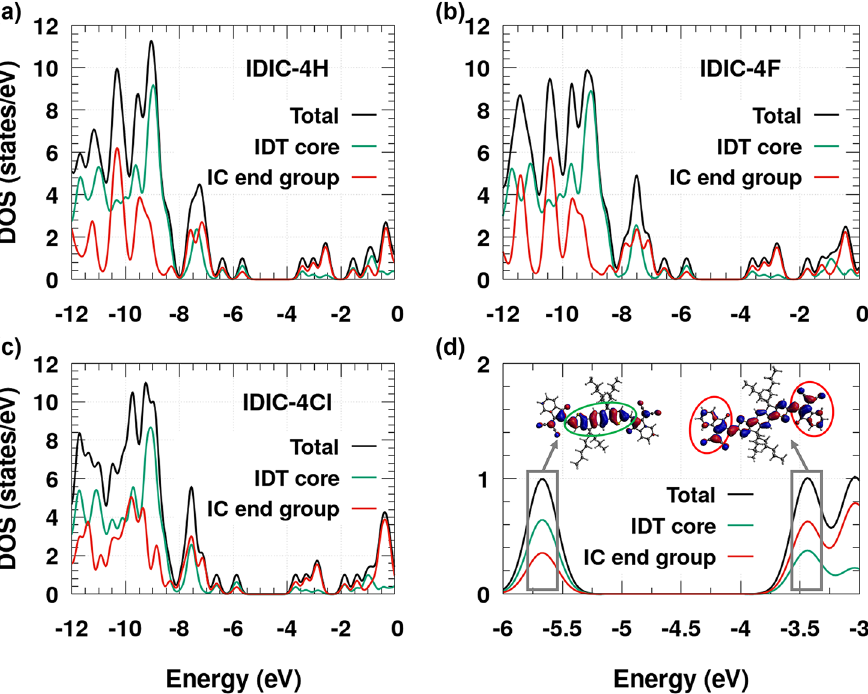
Fig. 4. Total and partial DOS for (a) the parent, (b) the fl uorinated, and (c) the chlorinated compound. (d) Contributions around HOMO and LUMO energy levels for the parent molecule IDIC-4H.